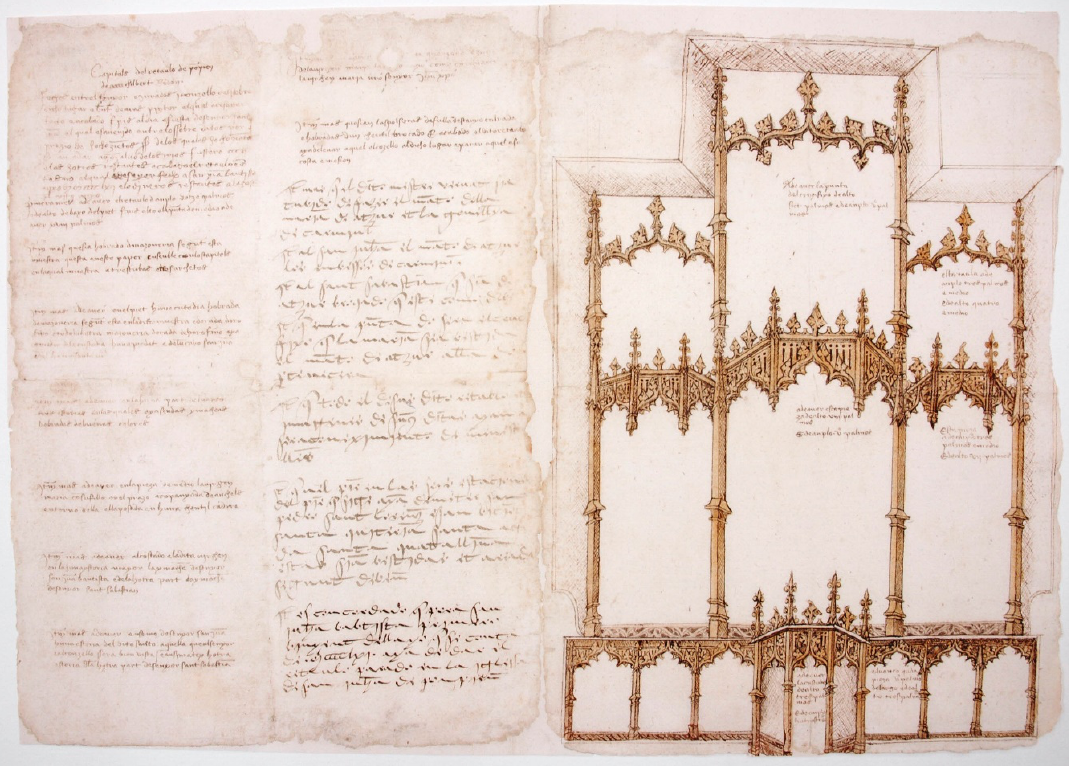
Figure 11. Project for an altarpiece dedicated to Our Lady in the parish church of Pompién (Huesca) [A.H.P.HU., ES/AHPHU-011837/9]. © Archivo Histórico Provincial de Huesca.